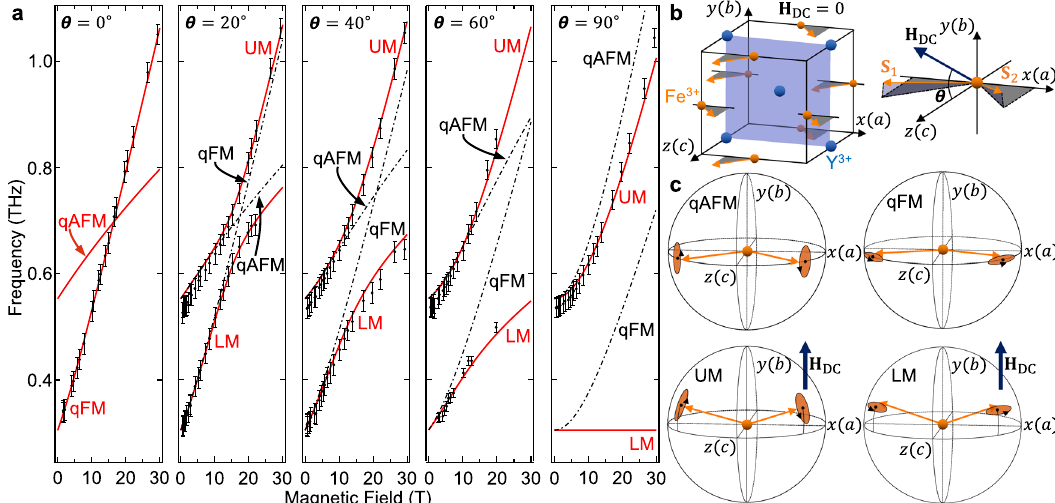
Fig. 3 Evidence for dominant vacuum Bloch-Siegert shifts. a Experimentally measured magnon frequencies for θ = 0 ∘ , 20 ∘ , 40 ∘ , 60 ∘ , 90 ∘ versus H DC (black dots) with calculated resonance magnon frequencies (solid red lines) and decoupled quasi-ferromagnetic (qFM) and quasi-antiferromagnetic (qAFM) magnon frequencies (black dashed-dotted lines). The upper mode (UM) frequency becomes lower than the qAFM frequency at θ = 90 ∘ , indicating a dominant VBSS compared to the VRSS. Error bars are 1/ T where T is the Fourier-transformed time-window and is limited by our THz detection. b Crystal and magnetic structure of YFeO 3 . c Spin dynamics in the decoupled qFM and qAFM modes, as well as the UM and lower mode